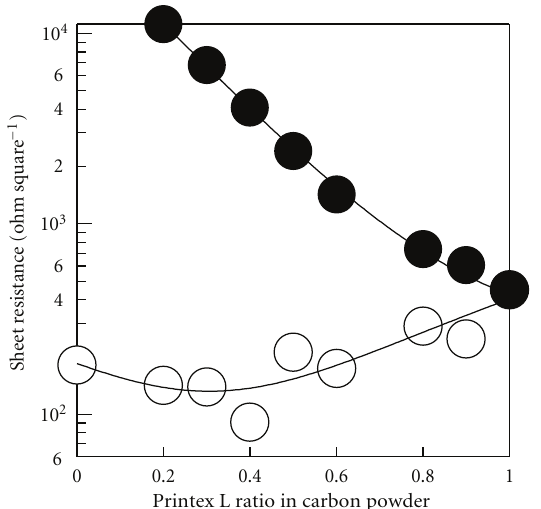
Figure 3: Relation between the carbon powder ratio (the ratio of Printex L in carbon powder) and sheet resistance of carbon electrode: amorphous nanocarbon (Printex L) and graphite ( (cid:3) ); amorphous nanocarbon (Printex L) and active carbon ( • ).